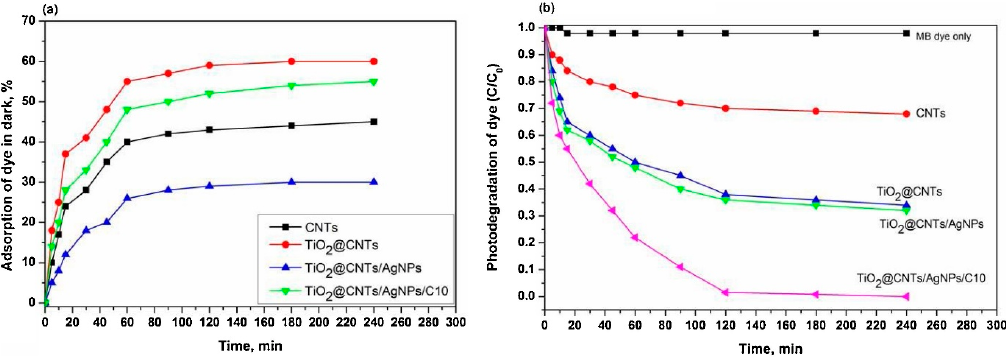
Figure 10. Degradation of methylene blue dye by ( a ) adsorption and ( b ) photodegradation under visible light [C 0 = 20 mg/L, catalyst dose = 0.5 g/L, pH = 5.8 and T = 25 °C]. Reprinted with permission from [185].